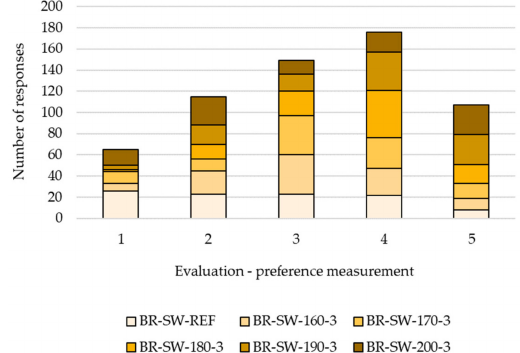
Figure 15. The color distribution of the samples depending on the preference level—solid birch wood. BR-SW-REF = untreated birch solid wood; BR-SW-160-3 = birch solid wood treated at 160 ◦ C / 3 h; BR-SW-170-3 = birch solid wood treated at 170 ◦ C / 3 h; BR-SW-180-3 = birch solid wood treated at 180 ◦ C / 3 h; BR-SW-190-3 = birch solid wood treated at 190 ◦ C / 3 h; BR-SW-200-3 = birch solid wood treated at 200 ◦ C / 3